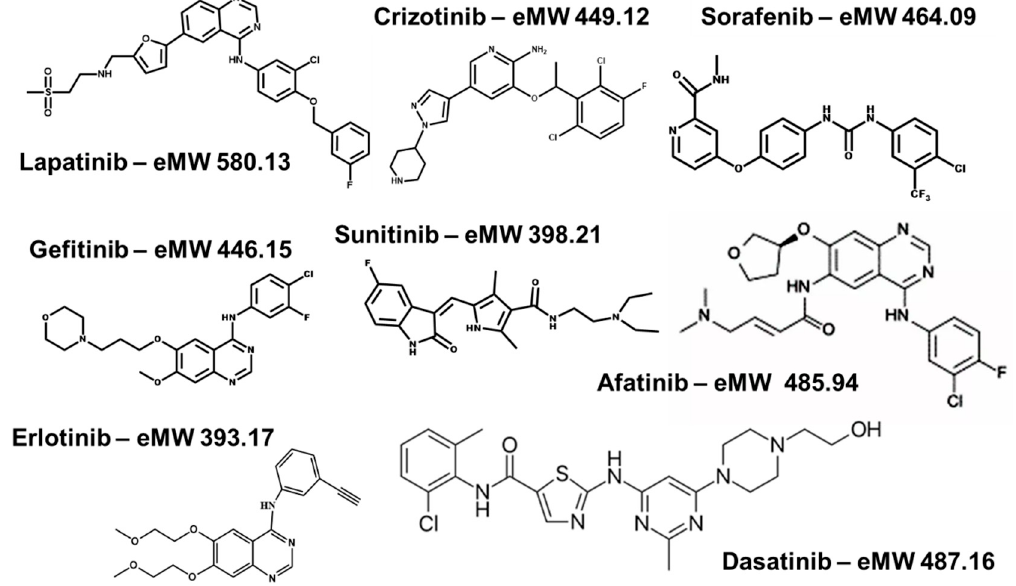
Figure 2. Molecular structures of the compounds under investigation for transport characteristics.